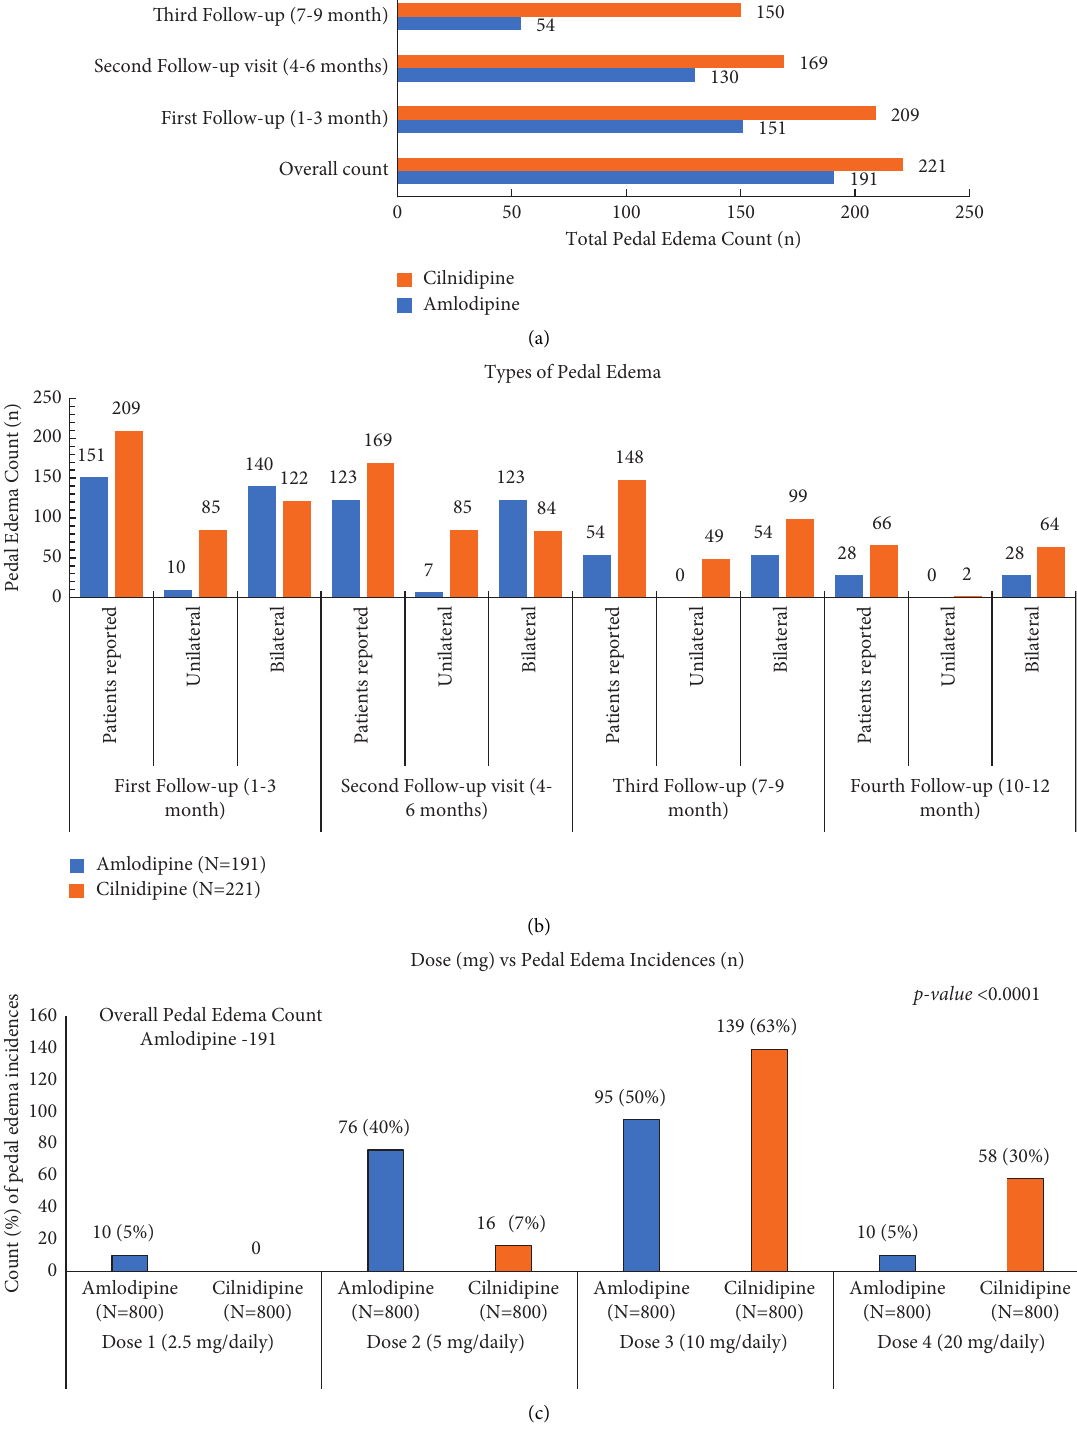
Figure 4: (a) Overall pedal edema count ( n ) reported timelines during the study period. (b) Types of pedal edema count during follow-up visits. (c) Dose (mg) vs pedal edema incidences ( n